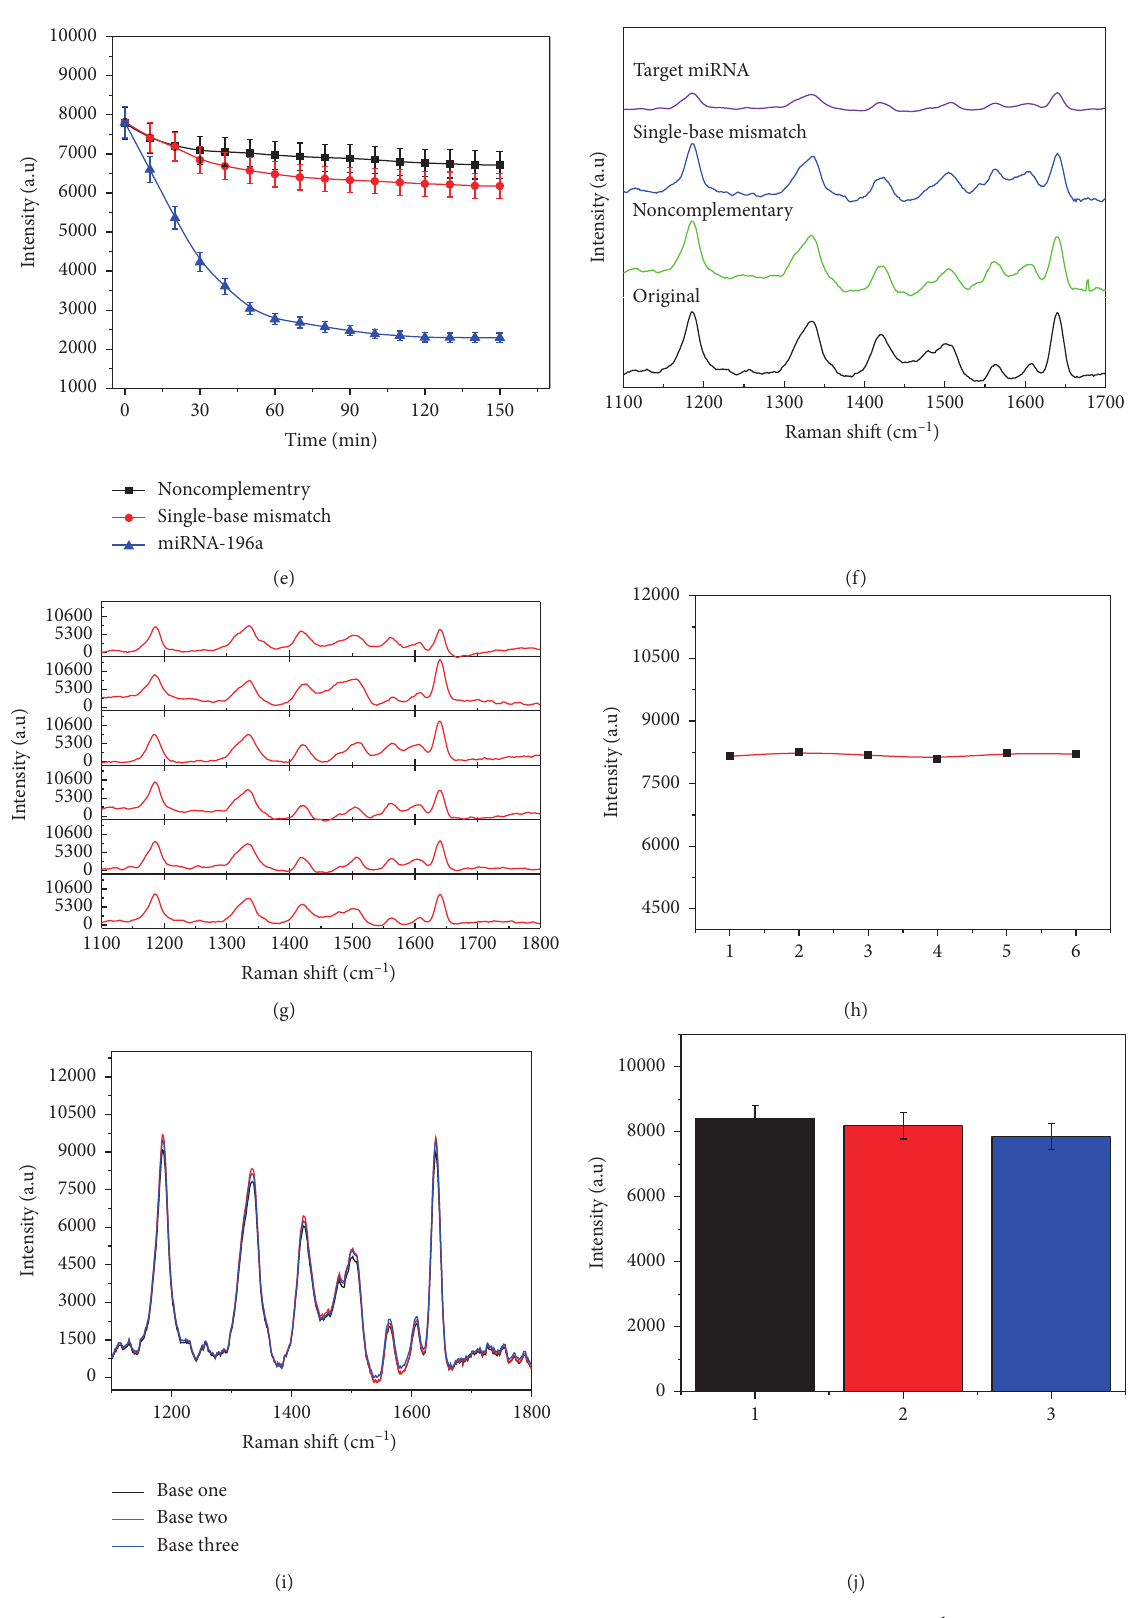
Figure 4: (a) SEM images of the AgNW@AuNPs substrate. (b) SERS mapping of NBA measured at 592cm − 1 using the AgNW@AuNPs substrate. (c) SERS spectrum of the AgNW@AuNPs substrate labeled DNA hairpin probe. (d) Assembly time-dependent SERS intensity at 1334cm − 1 . (e) Time change of SERS intensity for the complementary miRNA (blue triangle), single-base mismatch miRNA (red circle), and noncomplementary miRNA (black square). (f) SERS spectra of SERS platform before (original) and after incubation with 100 pM complementary, noncomplementary, and single-base mismatch miRNA. (g) SERS spectra at 1334cm − 1 from 6 random spots of the SERS platform after hybridization with 100pM miR-196a. (h) The line chart of the intensity at 1334cm − 1 corresponding to the SERS spectra in (g). (i) The reproducibility of the SERS platform. (j) The histogram of the intensity at 1334 cm − 1 corresponding to the SERS spectra in